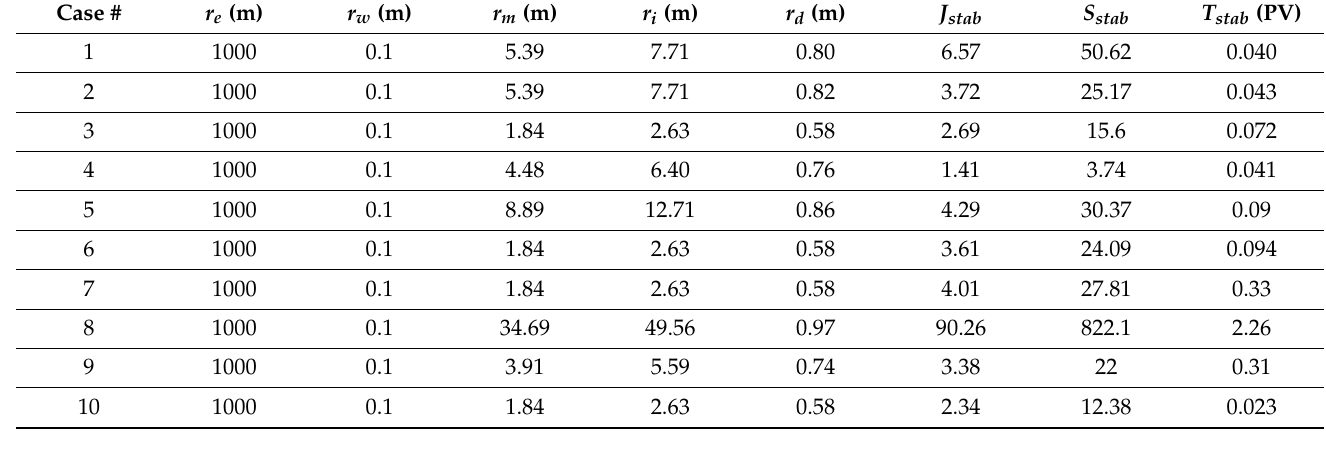
Table 5. Prediction of damaged-well exploitation parameters based on the well production history.